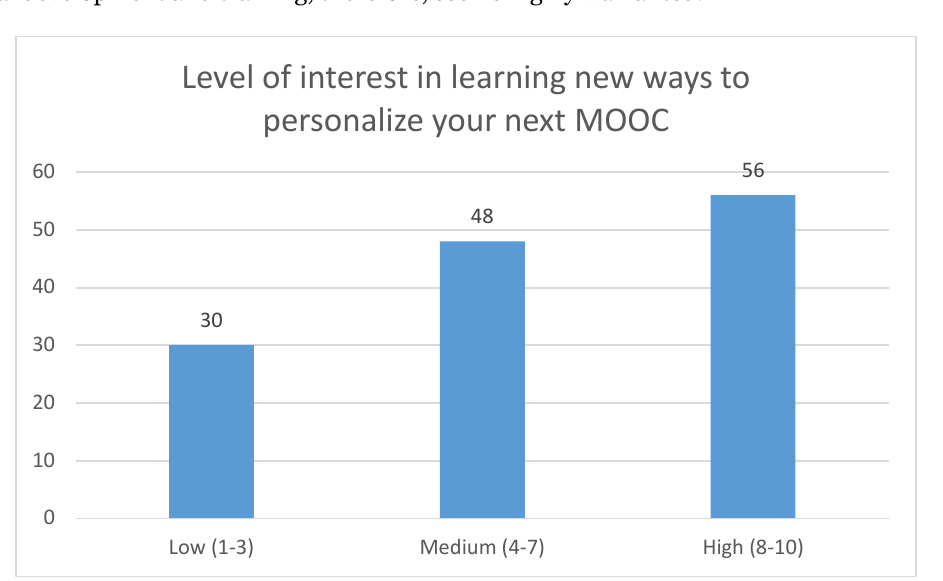
Figure 7. MOOC instructor interest in learning new ways to personalize their next MOOC offering. Note: on a scale of 1 (low) to 10 (high)